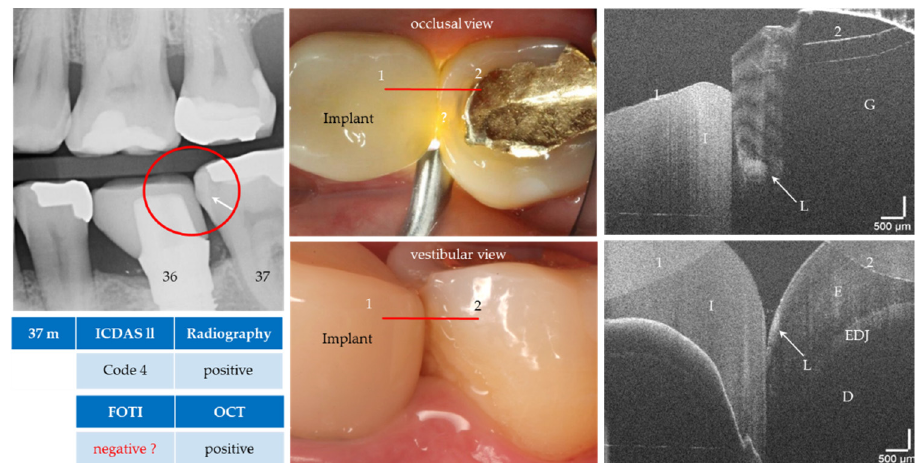
Figure 13. Tooth 37 (m). Apart from the FOTI, the enamel lesion (L, arrows) next to a gold inlay (G) was detected visually, radiographically and by OCT from both the occlusal and vestibular position. The proband was also able to confirm that a non-cavitated lesion had been detected before insertion of the implant crown (I, e.max CAD). The red lines mark the OCT cross-sectional planes. As a result of focusing on deeper structures, the tooth surface has flipped in the OCT images. Enamel (E), dentin (D), enamel-dentin junction (EDJ). The vertical scales are related to the refractive index n = 1.0 (see remark in Figure 4).